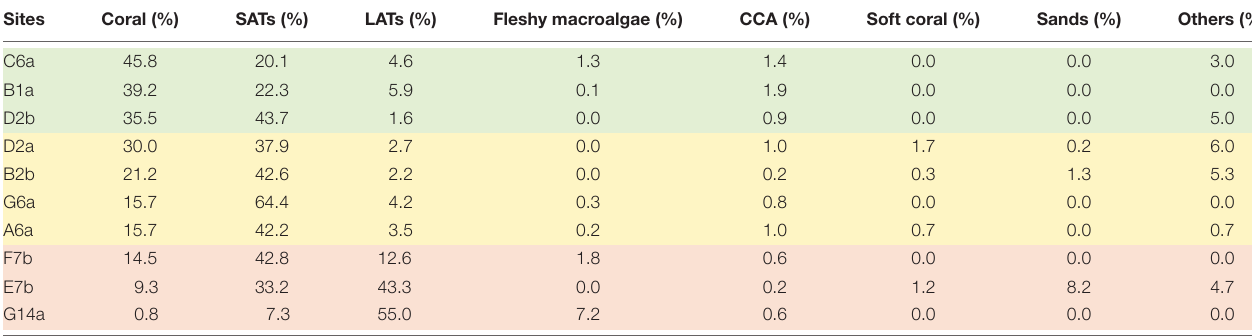
High coral cover reefs (HC, green area) were often characterized with moderate short algal turfs (SATs) and crustose coralline algae cover, reefs (IC, yellow area) with intermediate coverage of coral were characterized with high SATs cover, and low coral cover reefs (LC, red area) was often characterized with either high long algal turfs (LATs) cover or fleshy macroalgae cover. TABLE 2 | The distribution and sampling information of Ctenochaetus striatus at each